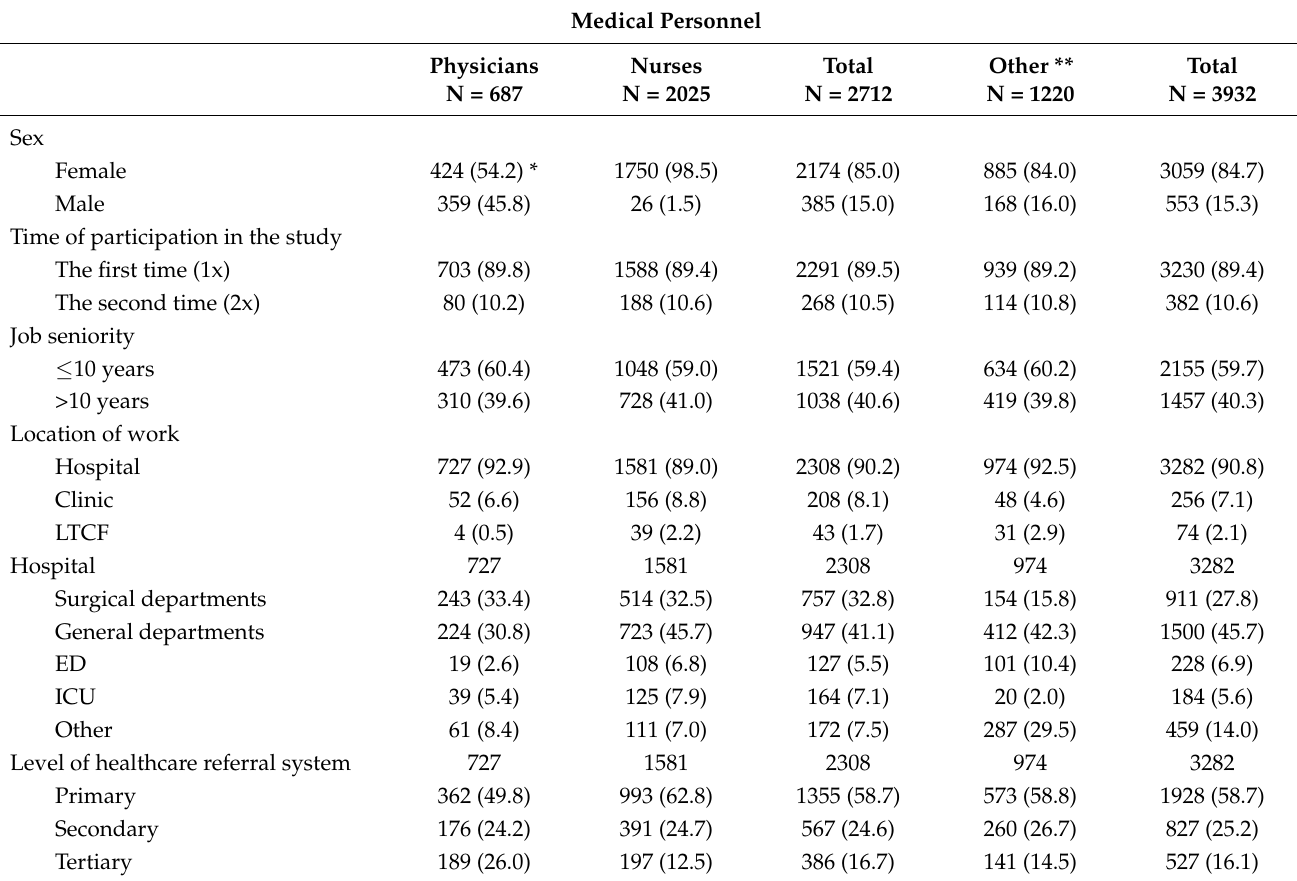
Table 4. Characteristics of personnel who do not adhere to the BBE concept (non-BBE group). Medical Personnel